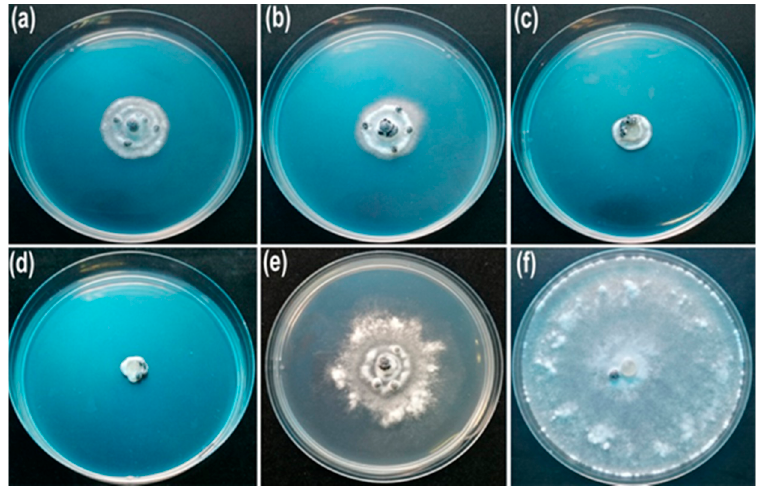
Figure 4. Effect of AgNPs on the hyphal growth of S. sclerotium on PDA 10 days after inoculation: ( a ) 50 μ g /mL; ( b ) 100 μ g/mL; ( c ) 150 μ g /mL; ( d ) 200 μ g/mL; ( e ) 50% cell ‐ free culture liquid (CFCL) of T. virens HZA14; ( f ) ddH 2 O. Table 2. Effect of AgNPs of different concentrations against the hyphal growth (HG), sclerotia